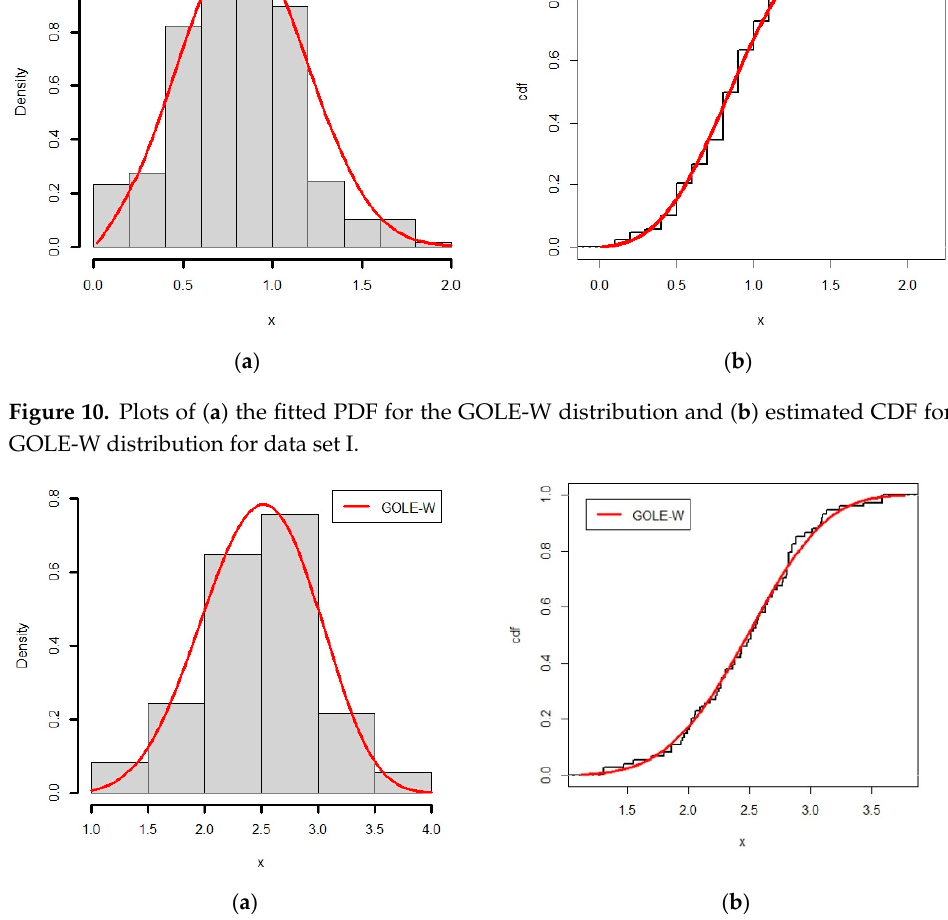
Figure 11. Plots of ( a ) the fitted PDF for the GOLE-W distribution and ( b ) estimated CDF for the GOLE-W distribution for data set II.